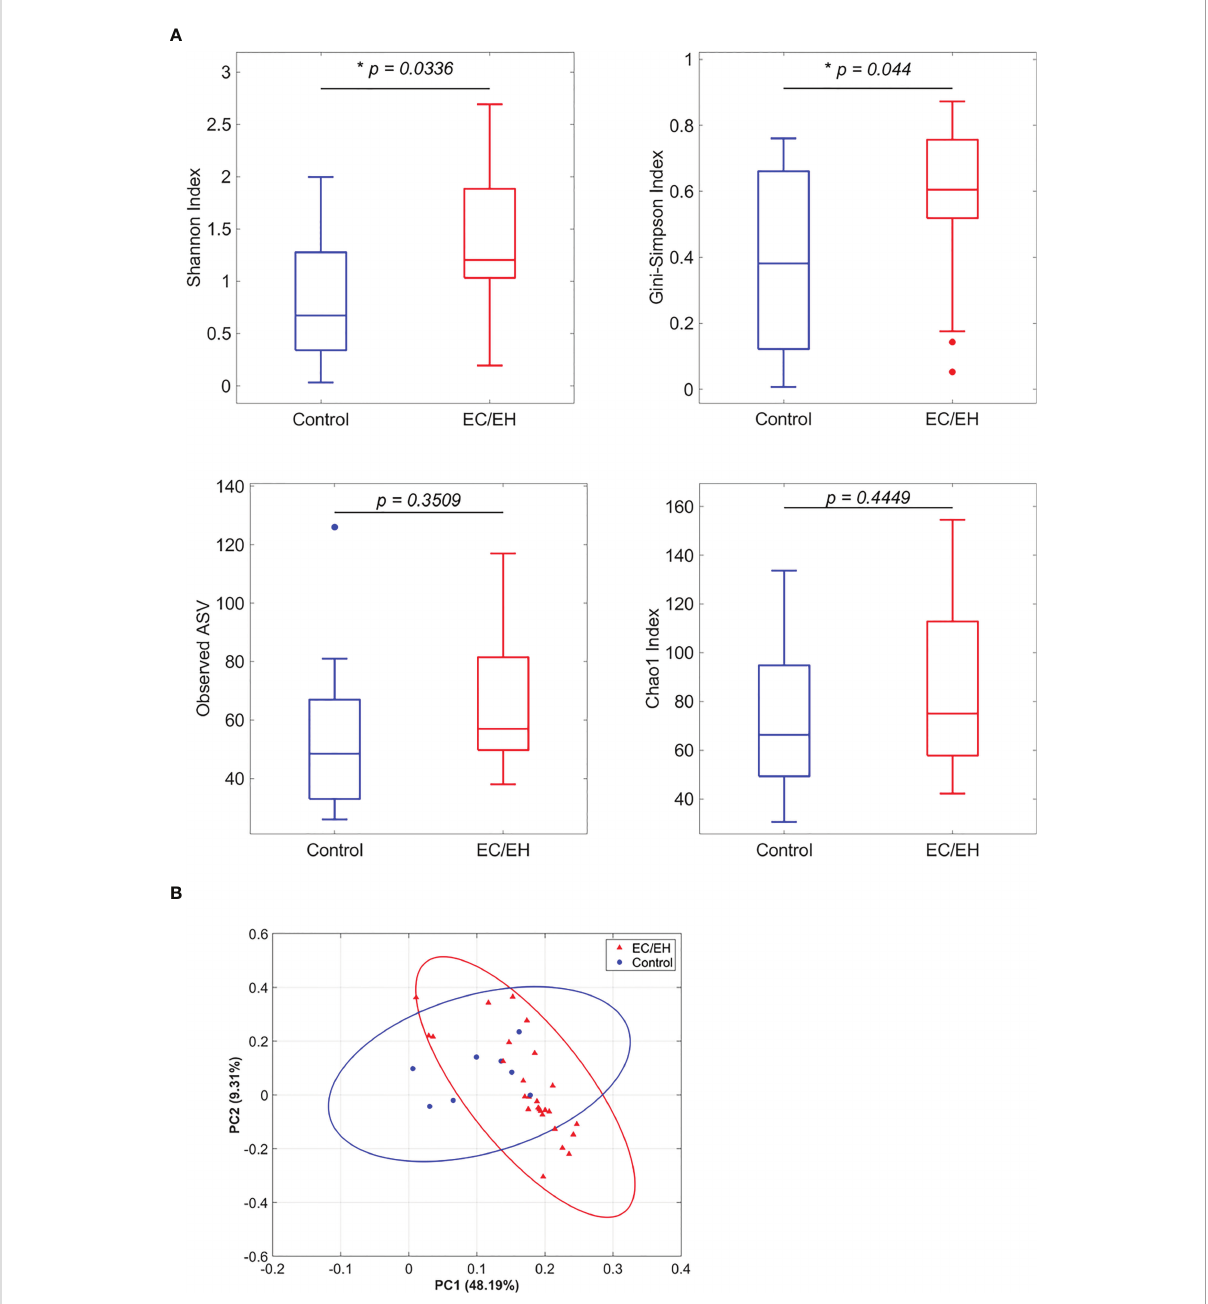
FIGURE 1 Analysis of endometrial lavage microbiota in patients with EC/EH versus control women. (A) Richness and diversity indices. (B) Principal component analysis based on unweighted UniFrac distances. “ * ” means statistically signi fi cant